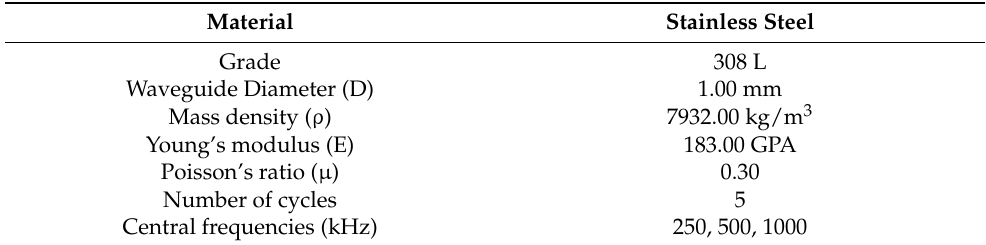
Table 1. Finite element method (FEM) and waveguide parameters.